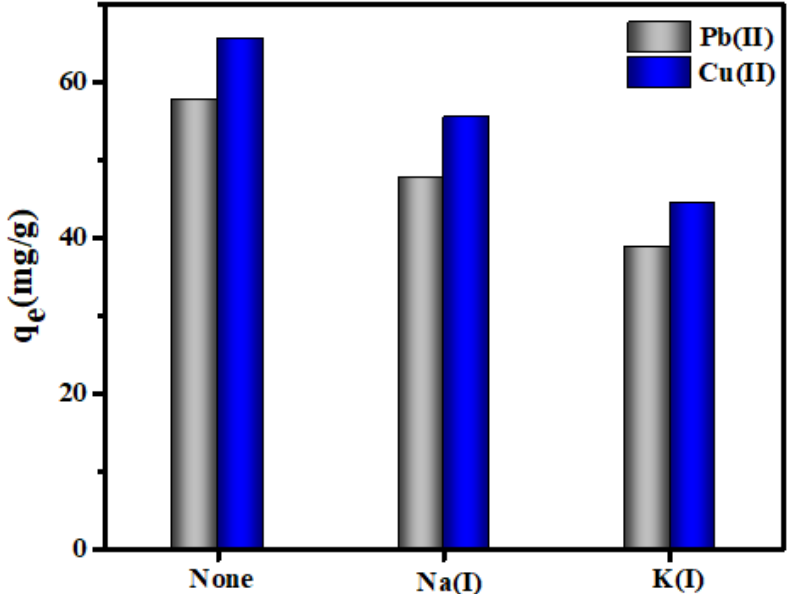
Figure 4. ( a ) Impact of initial Pb(II) and Cu(II) concentration on the adsorption onto MgO nanorods at pH = 3, ( b ) the effect of pH on % elimination of Pb(II) and Cu(II) with an initial concentration of 45 ppm.